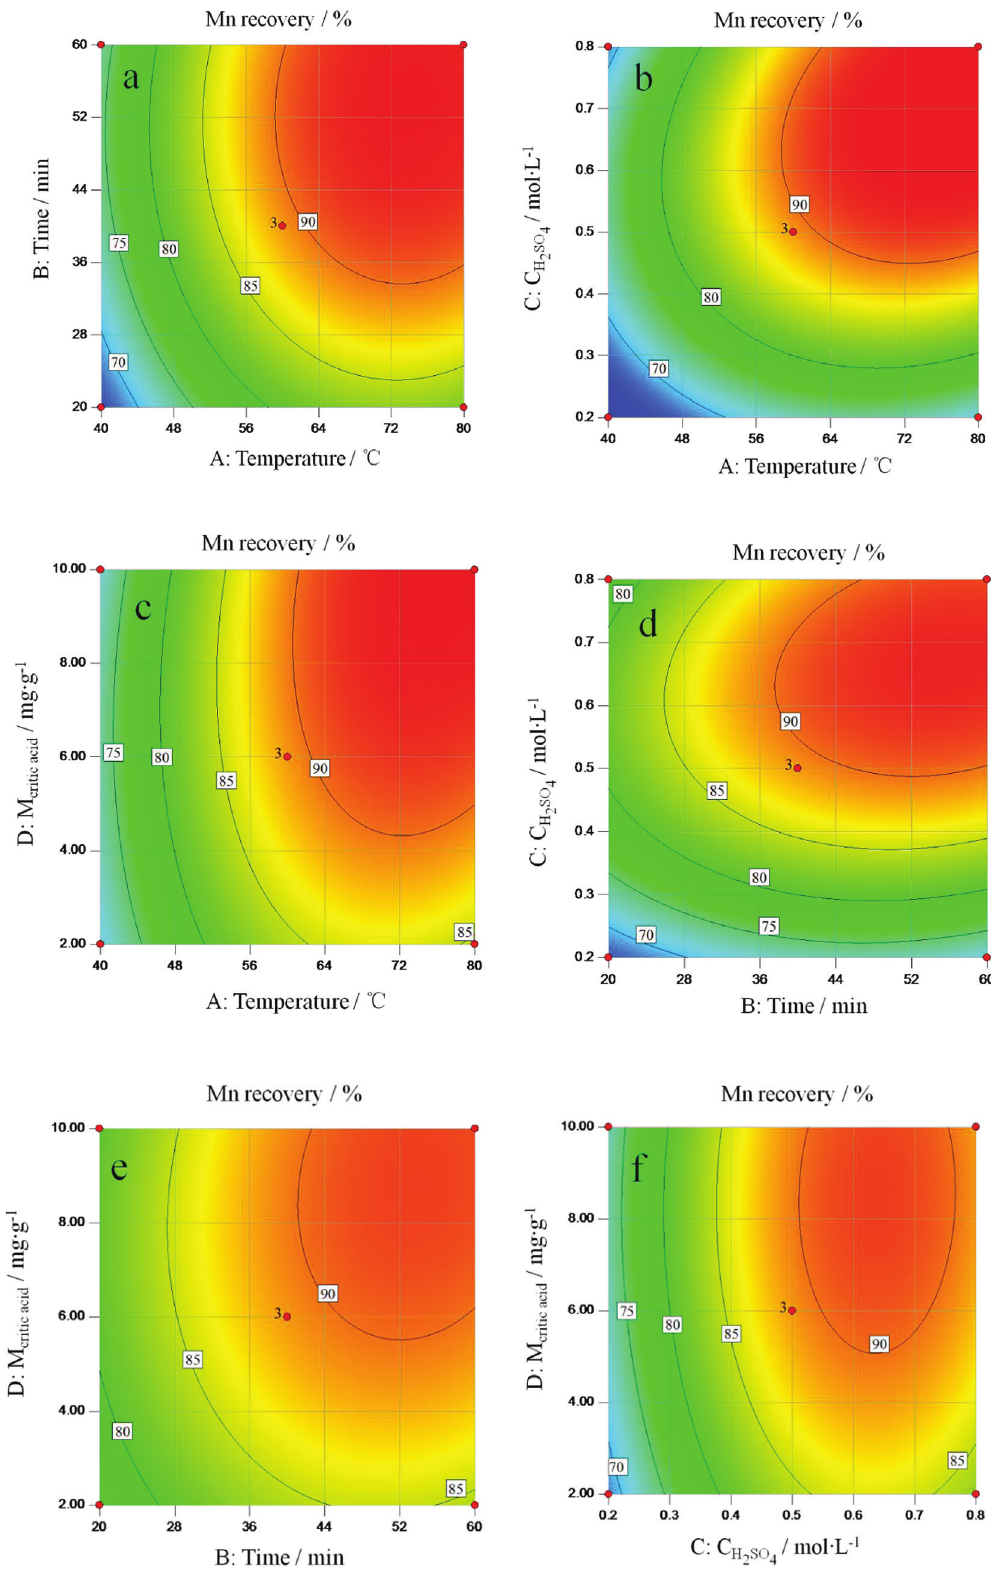
), time ( X ), H SO concentration ( X 1 2 2 4